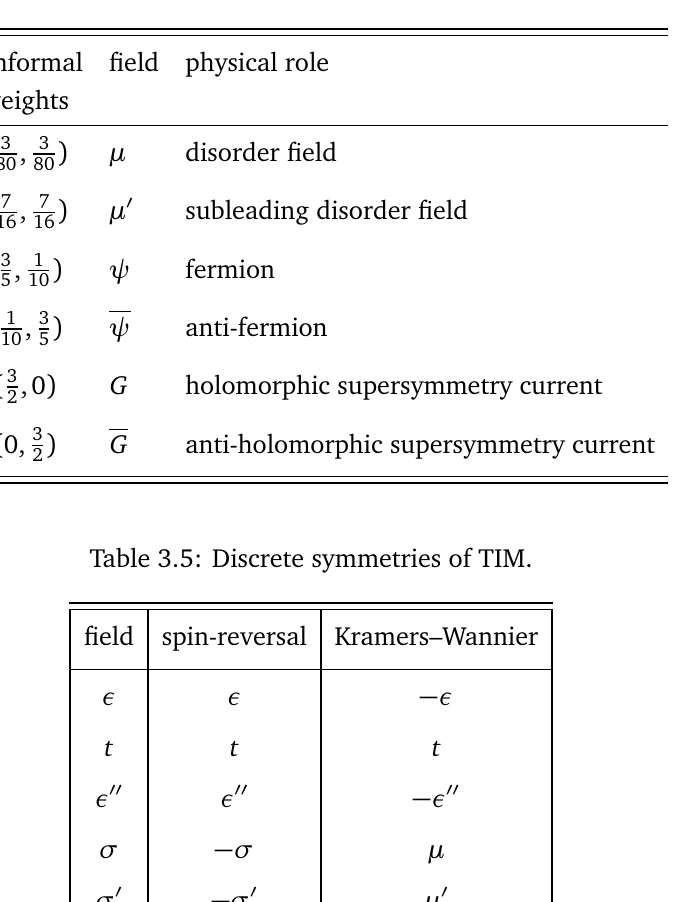
Table 3.4: Additional operators of the TIM originating from the supersymmetry of the model.